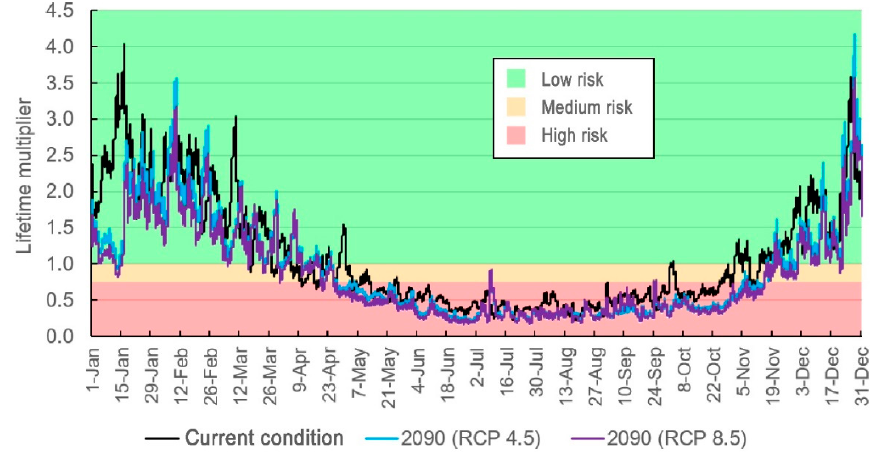
Figure 10. Evaluation of the deterioration of the protective varnish of paintings (yellowing). LM trend for the different scenarios analysed.